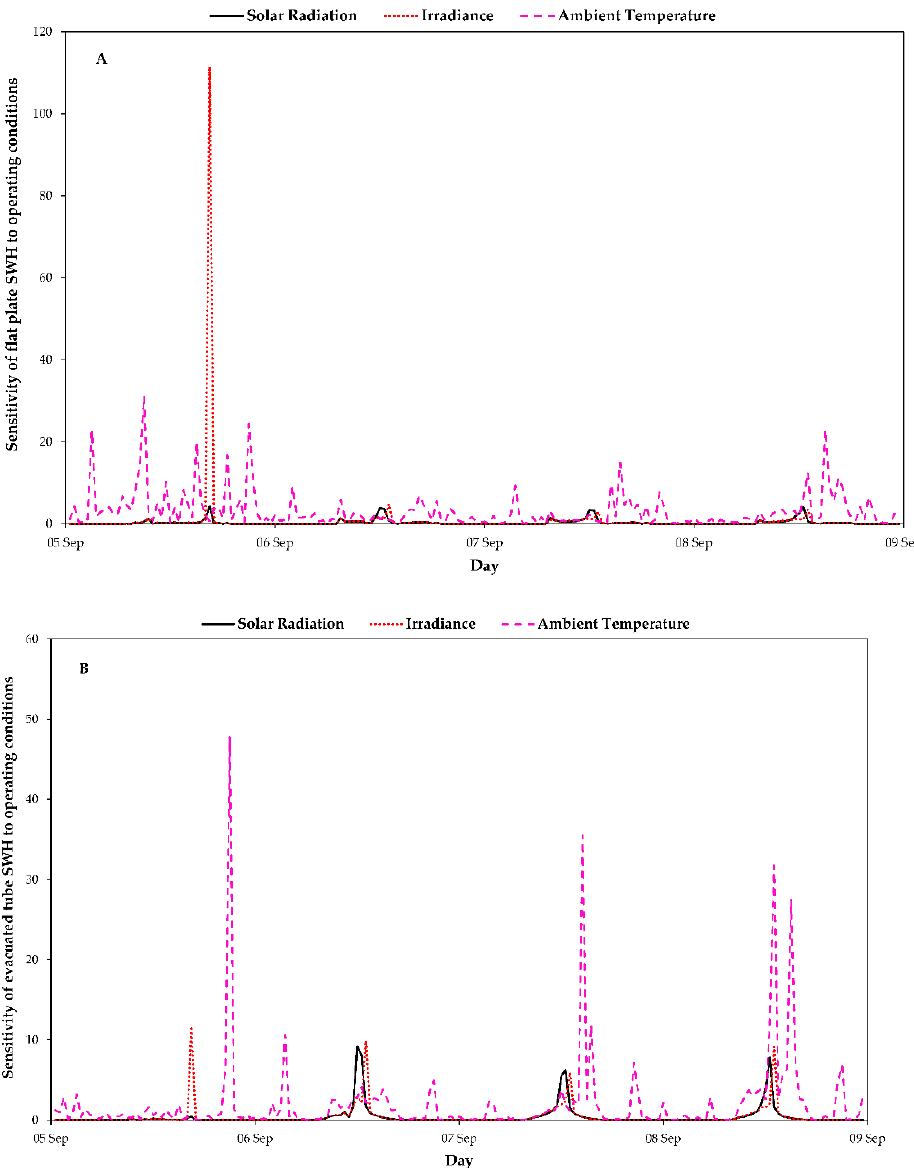
Figure 13. Sensitivity of hot water production by ( A ) flat plate and ( B ) evacuated tube solar water heaters to measured operating conditions. Table 3. Payback period for a flat plate and evacuated tube solar water heater used in the domestic sector. System Flat Plate Evacuated